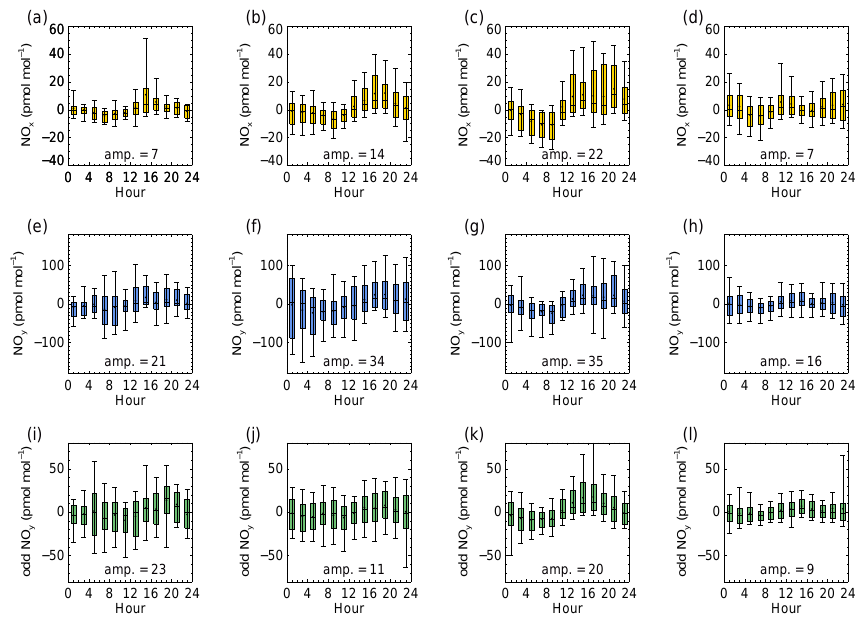
Figure 4. Average diurnal cycle of ambient NO x (a, b, c, d) , NO y (e, f, g, h) , and odd NO y (i, j, k, l) measured at Summit for the months March (1st column), April (2nd column), May (3rd column), and June (4th column) 2008–2010. Median ambient levels observed each day were subtracted, to remove any impact from day to day variability. The median and mean of the data are represented by a horizontal line, and filled black circle, respectively; the box indicates the middle 67% of the data; and the vertical whiskers indicate the 5th and 95th percentile of all the data. Times are shown as local time (UTC). The amplitude of the diurnal cycle (given as the difference between the lowest and highest 2h median values, in pmolmol − 1 ) is noted on each